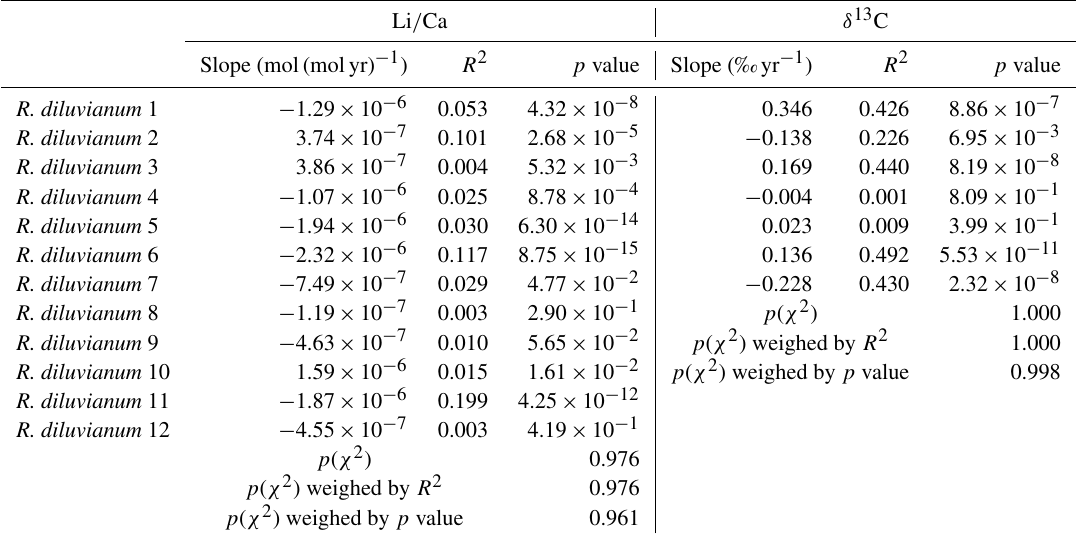
Table 1. Overview of the slopes of ontogenetic trends in Li / Ca and δ 13 C records. p values on the bottom of the table show that the distribution of Li / Ca slopes is statistically indistinguishable from